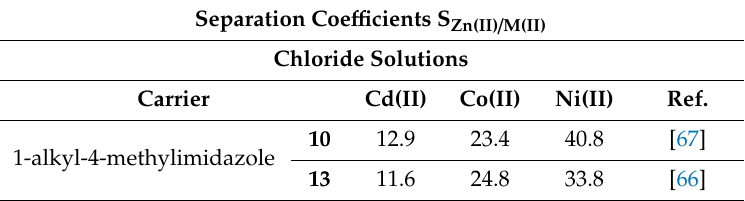
Zn–Cd–Co–Ni equimolar solutions after a 24-h transport.